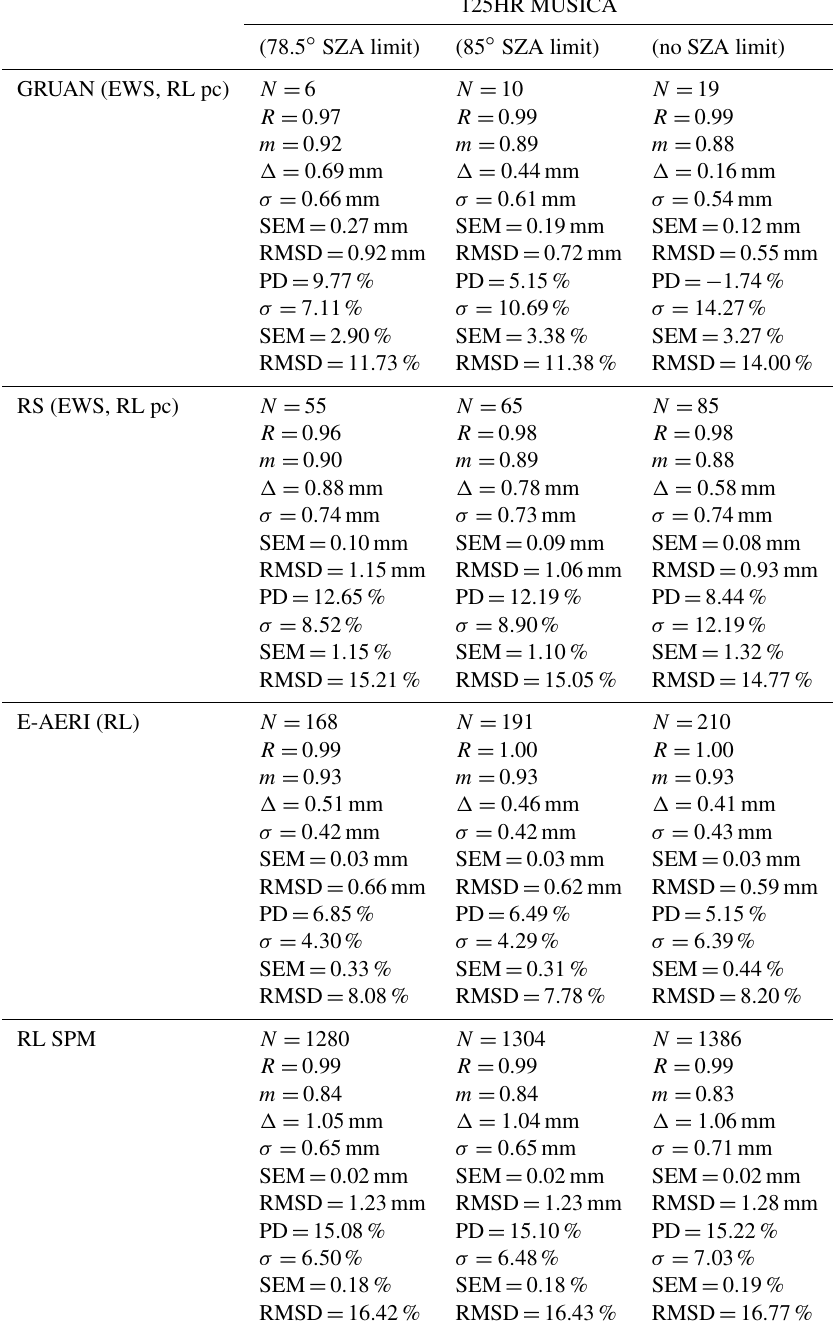
Table 3. Summary of total column comparison of 125HR with different SZA limits ( X in Eqs. 1 and 2) with co-located Eureka instruments ( Y in Eqs. 1 and 2). Reported values include number of coincidences ( N ), correlation coefficient ( R ), slope of correlation best fit line ( m ), mean difference ( (cid:49)) , standard deviation of difference ( σ) , standard error of the mean (SEM), and root-mean-square difference (RMSD) inmm and%. GRUAN and RS values are partial columns (pc) integrated from the RL altitude and